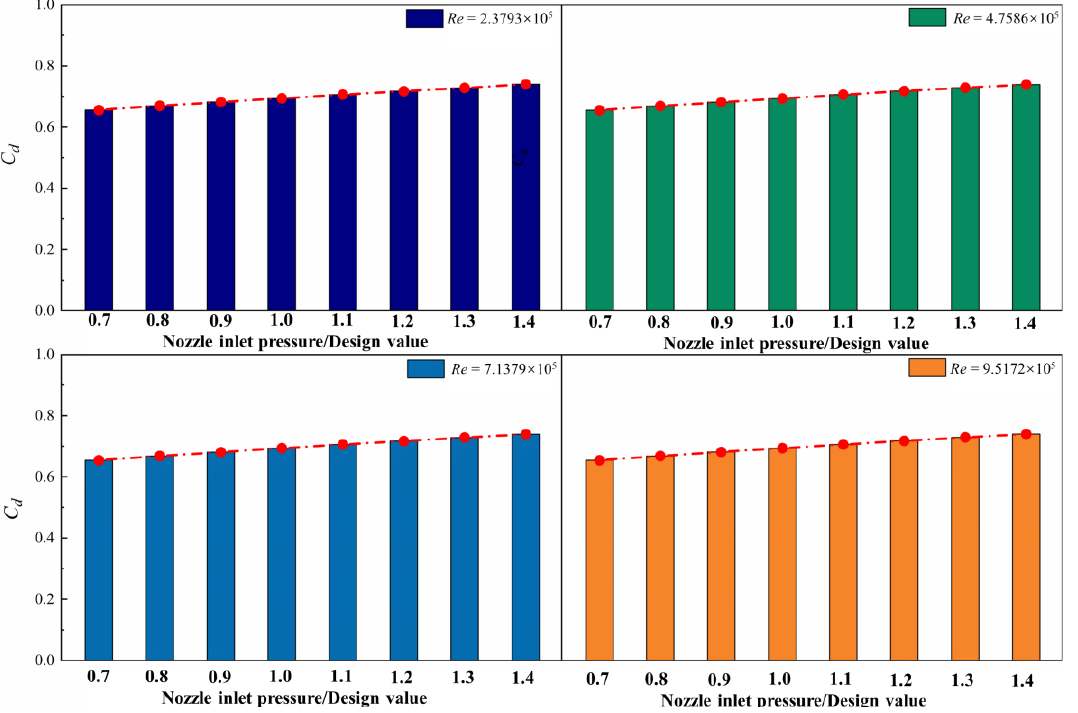
Figure 11. Distribution of flow rate coefficients of pre-swirl nozzle at different Re .